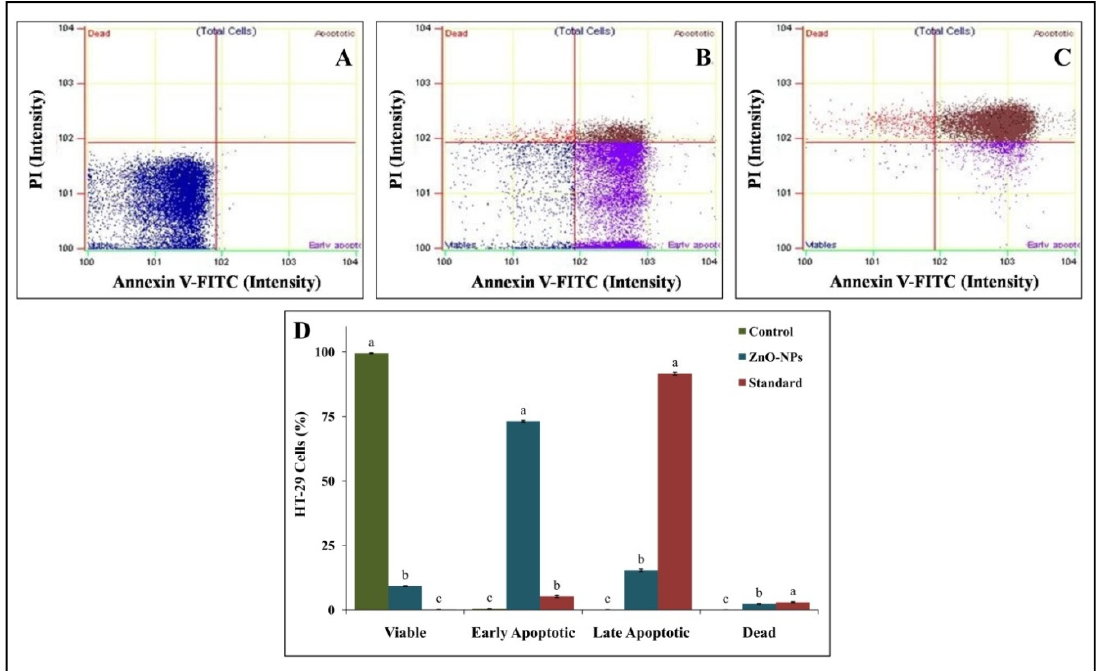
Figure 11. Representative graph of flow cytometry analysis of HT-29 cells with Annexin-V fluo- rescein isothiocyanate (FITC). ( A ): Control; ( B ): ZnO-NPs; ( C ): Colchicine; ( D ): Percentage of HT-29 ( A ): Control; ( B ): ZnO-NPs; ( C ): Colchicine; ( D ): Percentage of HT-29 cells. Each value is the mean of three replicates cells. Each value is the mean of three replicates (n = 3) and bars sharing the same letters are not (n = 3) and bars sharing the same letters are not significantly different ( p ≤ 0.05) according to Tukey’s HSD. The vertical bar significantly different ( p ≤ 0.05) according to Tukey's HSD. The vertical bar indicates the standard indicates the standard error.